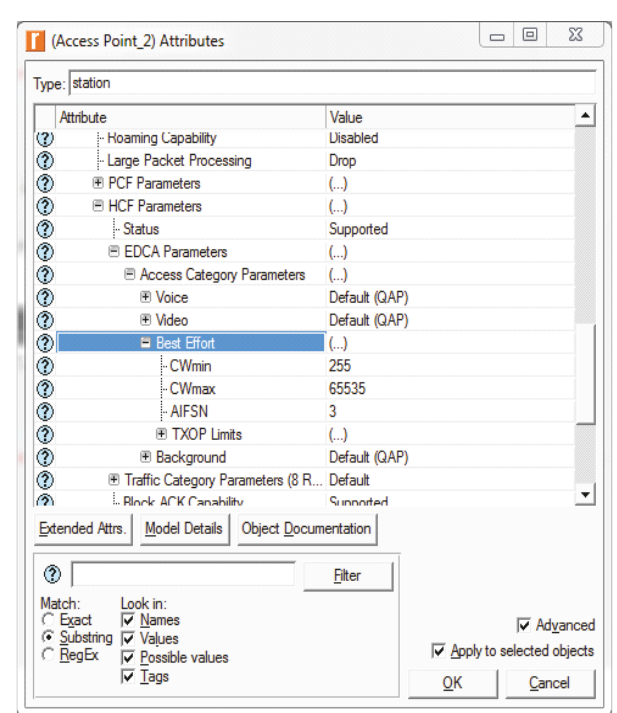
Figure 33: Optimized values of CWmin and